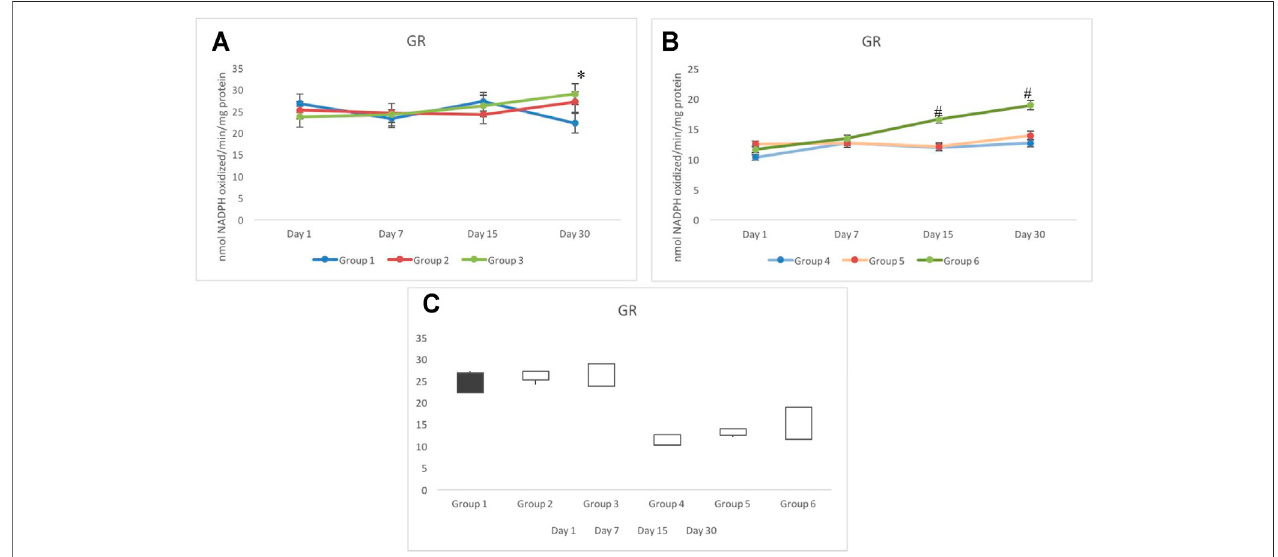
FIGURE 6 | Activity of glutathione reductase (GR) in non-exposed (A) and exposed (B) animals pretreated with CRE/CRE-AgNPs. Gain and loss in activity is indicated with white and black boxes, respectively (C) . * p < 0.05 signi fi cance level was measured against group 1. # p < 0.05 signi fi cance level was measured against group 4.